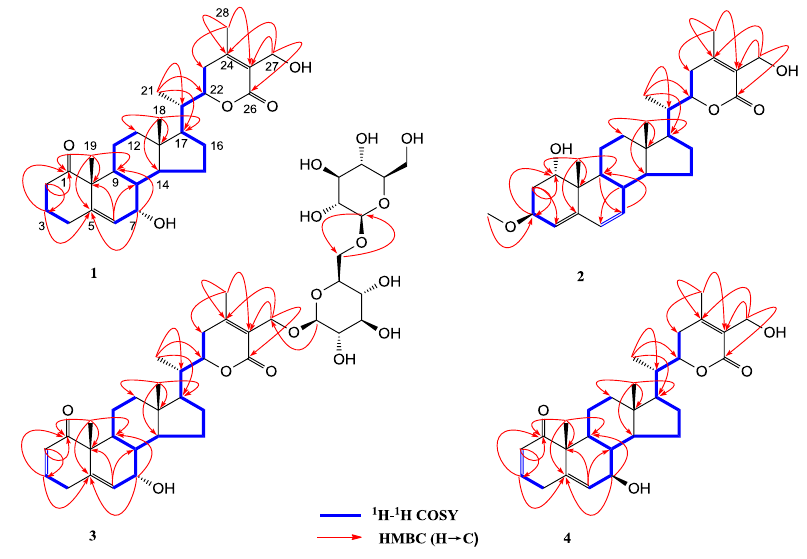
Table 2. 13 C-NMR (100 MHz) data of the aglycones of 1 – 4 (in CD